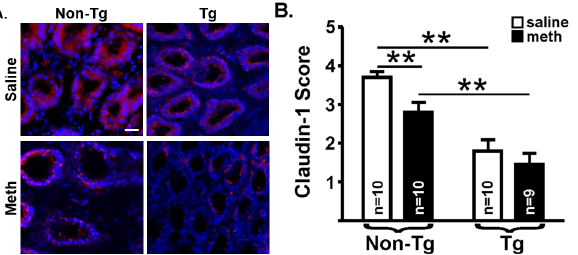
Fig 4. Claudin-1 immunofluorescence. (A) Representative photomicrographs of claudin-1 immunofluorescence (red) in the distal colon of saline-yoked (top) and methamphetamine (meth) self-administering (bottom) non-Tg (left) and Tg (right) rats. Sections were counterstained with DAPI (blue) to identify crypts. Colon tissue from saline-yoked non-Tg rats exhibited continuous, intense claudin-1 immunofluorescence around the epithelial cells within the crypts (top, left) ; whereas colons from saline-yoked Tg rats exhibited light, continuous claudin-1 immunofluorescence ( top, right ). Non-Tg rats that self-administered methamphetamine had discontinuous claudin-1 immunofluorescence ( bottom, left ). Tg rats that self-administered methamphetamine ( bottom, right ) displayed the least amount of claudin- 1 immunofluorescence. White bar = 25μm. (B) A scale from 0–4 was used to score claudin-1 immunofluorescence (see Methods). As indicated by horizontal lines above the bars, scores differed significantly between saline-yoked (open bars) non-Tg and saline-yoked Tg rats, methamphetamine self-administering (filled bars) non-Tg and Tg rats, and saline- yoked non-Tg and methamphetamine self-administering non-Tg rats. Mann-Whitney U -testscorrected for multiple comparisons ( (cid:3)(cid:3) p < 0.01).